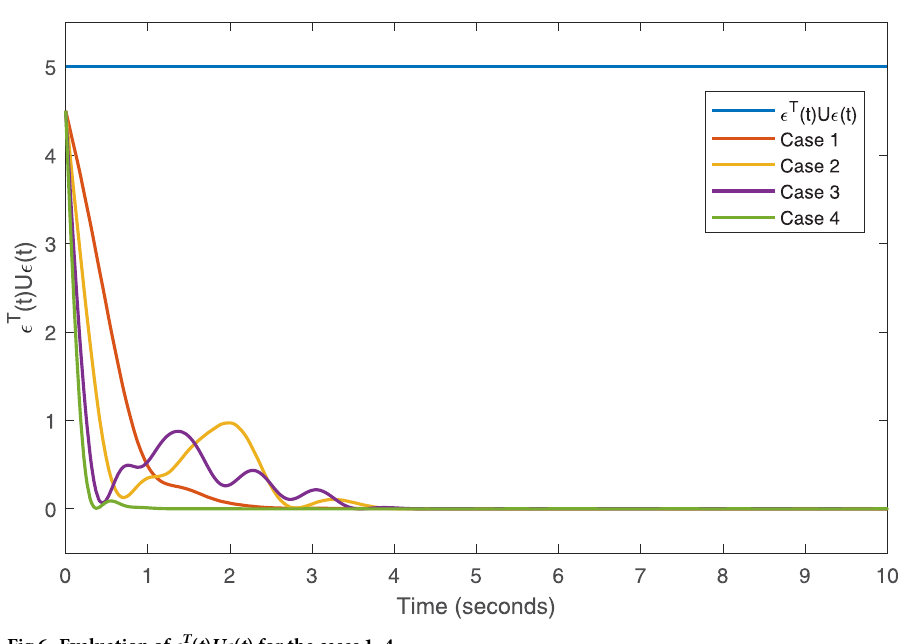
Fig 6. Evaluation of � T ( t ) U � ( t )for the cases 1–4.